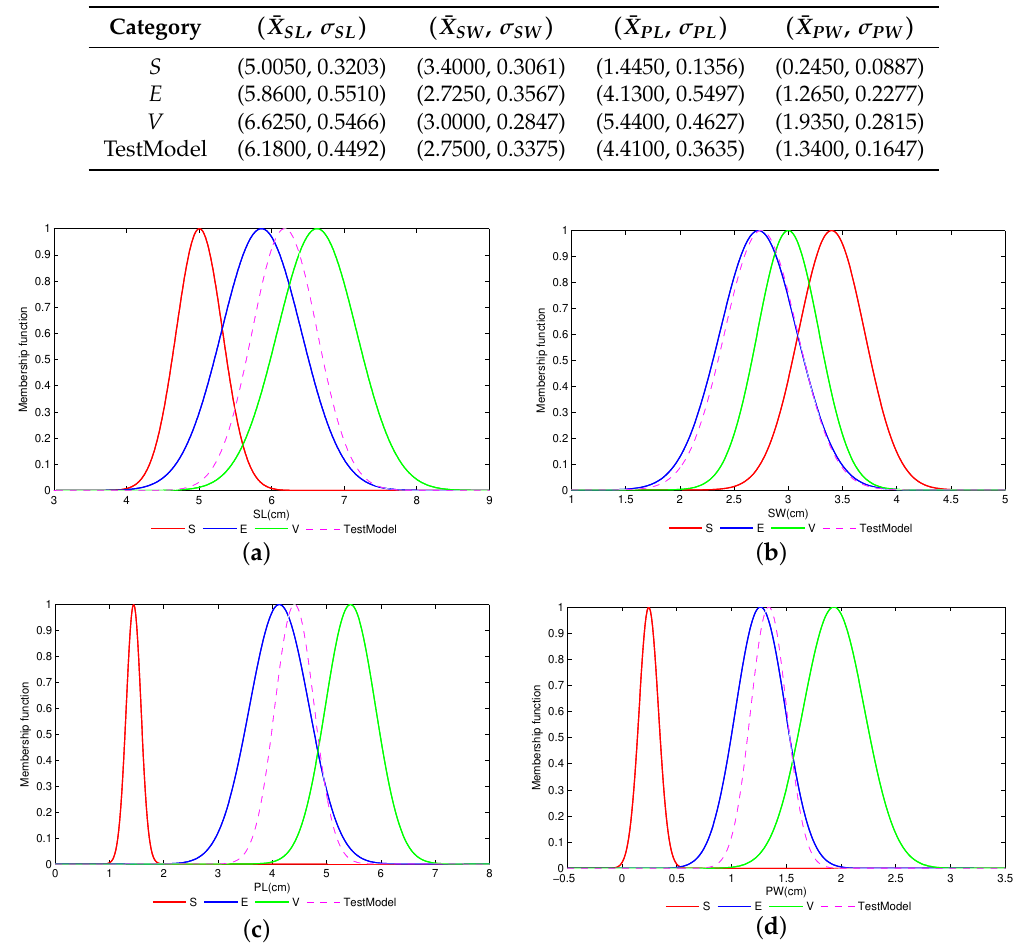
Table 1. Mean value and standard deviation of training models ( S , E , V ) and test models.